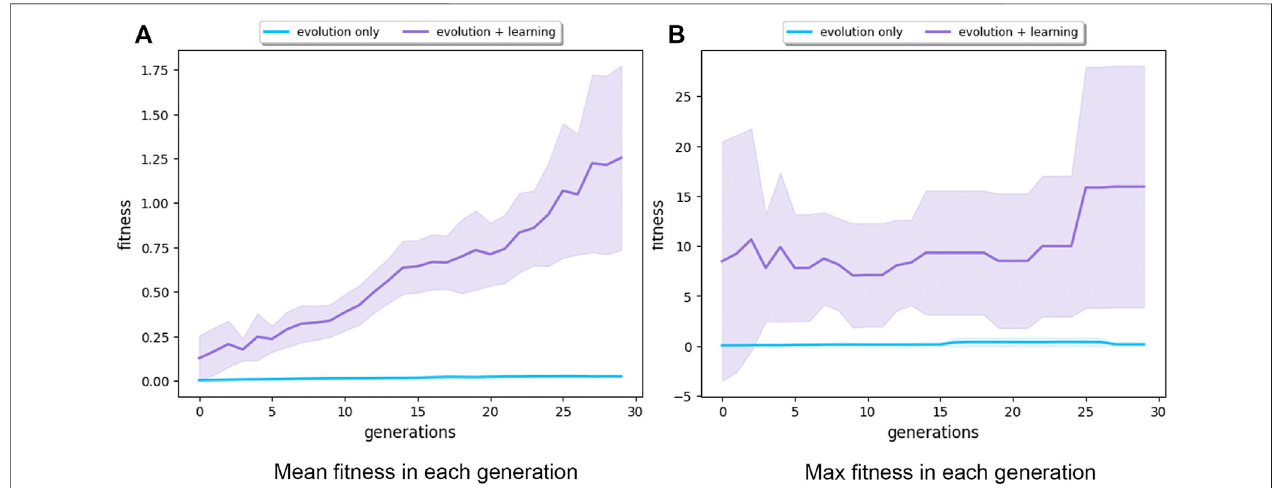
FIGURE 6 | Sub fi gure (A) shows the mean fi tness over 30 generations (averaged over 10 runs) for Evolution-Only in blue and Evolution + Learning in purple. The Evolution + Learning method already surpassed in its fi rst generation the fi tness levels that the Evolution-Only method achieved at the end of the evolutionary period. Sub fi gure (B) exhibits the maximum fi tness in each generation (averaged over 10 runs). The shaded areas show the standard deviation. Note the different scales on the vertical axes.